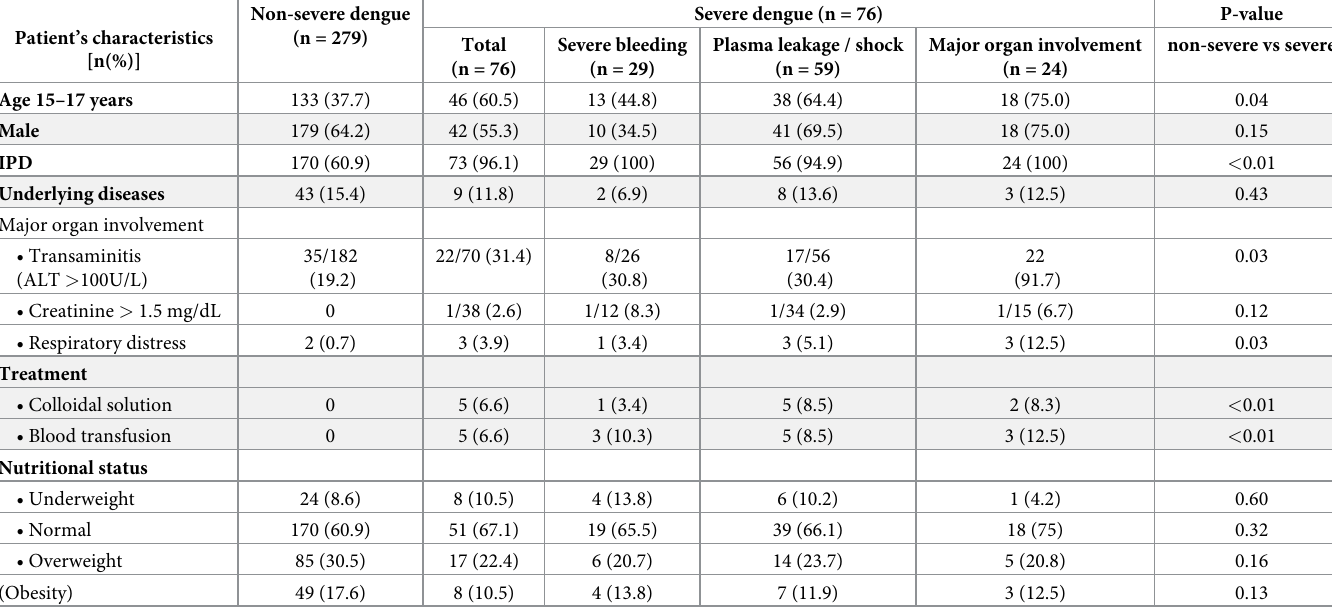
Table 3. Patient’s characteristics by 2009 WHO classification. Patient’s characteristics [n(%)]